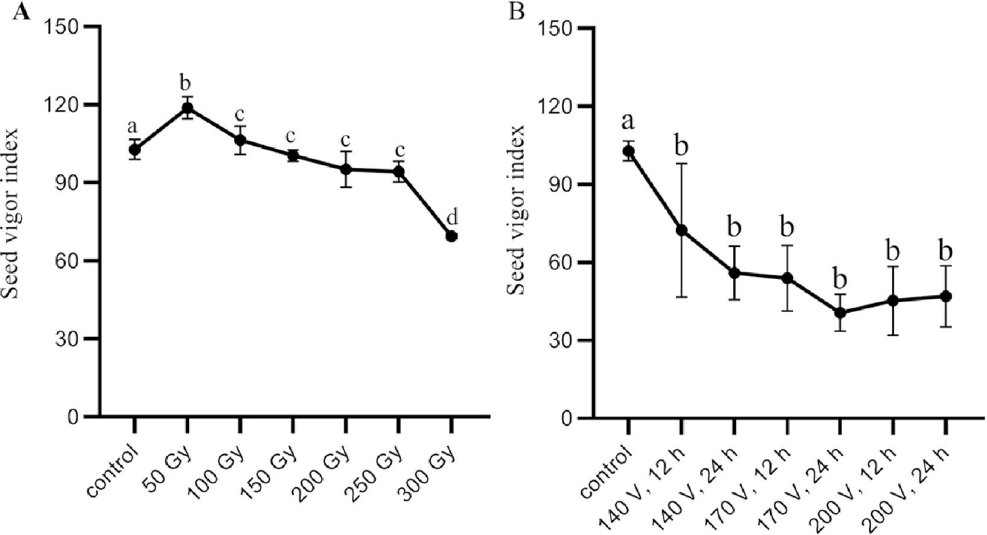
Figure 3. Seed vigor index after treated with ( A ) γ-irradiation; ( B ) DC electrophoresis bath. The error bars stand for standard deviations and the black dots ( ● ) for mean values, different letters on the top of the error bars mean significant difference at 5% level (n =